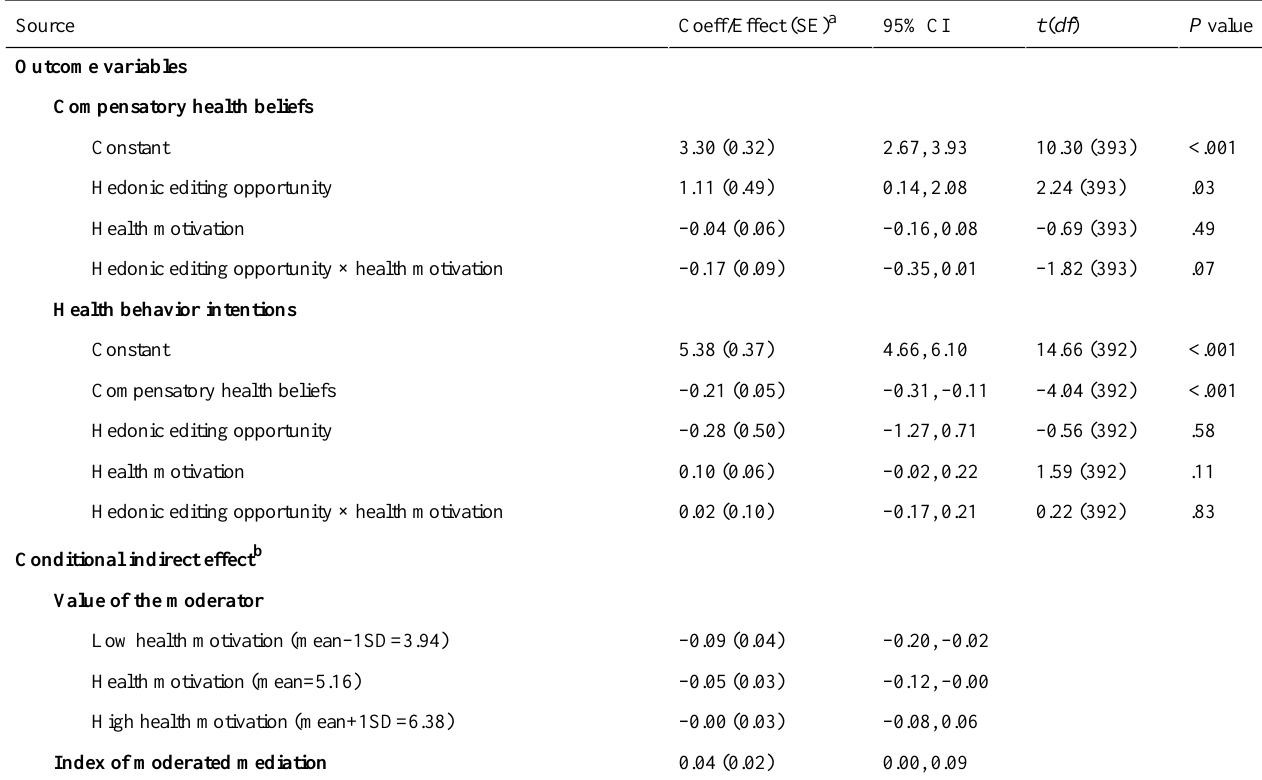
Table 1. Results of the moderated mediation analysis (not mean-centered).